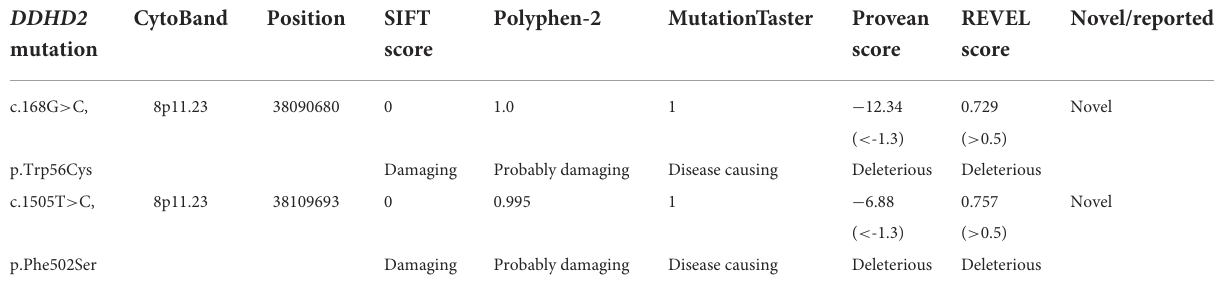
TABLE 1 Evaluation of the DDHD2 mutations identified in this study.